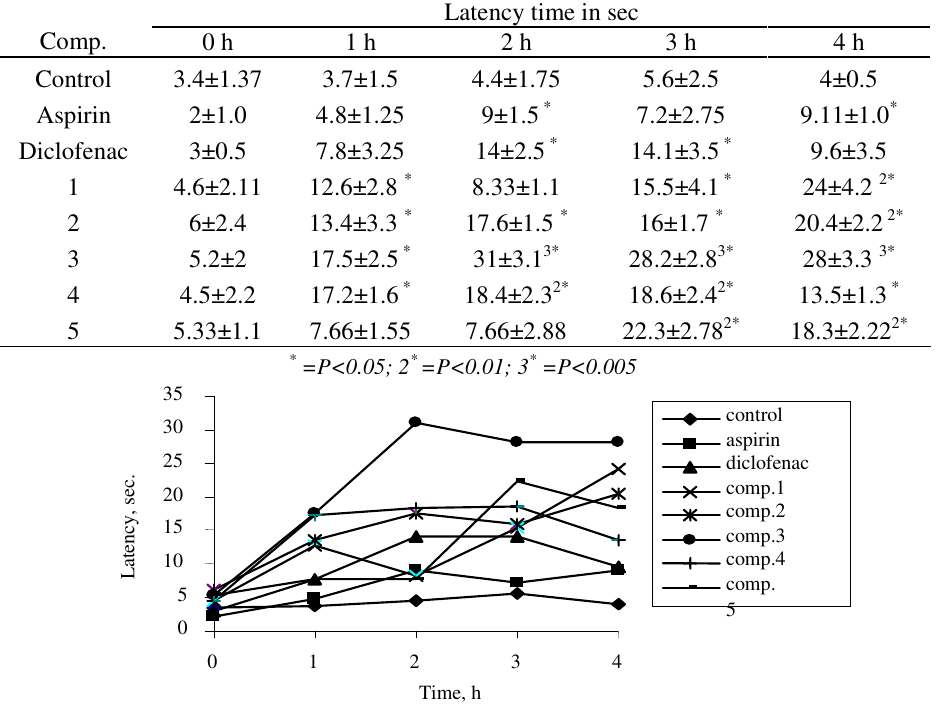
Figure 7. Hot plate tests of histidine derivatives